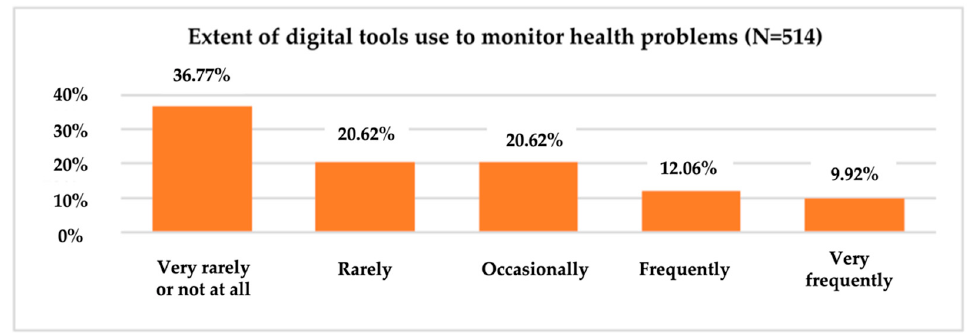
Figure 7. The use of digital tools to monitor health problems.